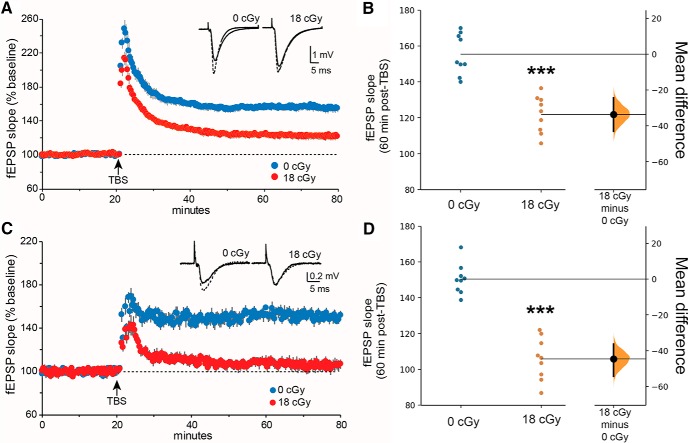
Neutron irradiation alters long-term synaptic plasticity in the hippocampal area CA1 and ventral medial prefrontal cortex. A, B, Extracellular field recordings following stimulation of the Schaffer-commissural projections to the proximal apical dendrites of field CA1b of the dorsal hippocampus, 6 months following completion of the 18 cGy neutron irradiation. A, Following a stable 20 min baseline recording, a single train of TBS was applied and baseline recordings were resumed for an additional 60 min. The time course shows that TBS-induced LTP was markedly reduced in slices from irradiated mice compared with slices from 0 cGy control mice. Inset, Representative traces collected during baseline (solid line) and 60 min post-TBS (dotted line). B, Field EPSP slope was significantly reduced 60 min post-TBS in slices from the neutron-irradiated mice compared with controls. C, D, Field responses recorded in cortical layer III following stimulation of glutamatergic inputs in cortical layer IV of the ventral medial prefrontal cortex. C, Similar results were obtained as shown in A. TBS-induced LTP was nearly completely blocked in slices from neutron-irradiated mice relative to controls. Inset, Representative traces collected during baseline (solid line) and 60 min post-TBS (dotted line). D, Field EPSP slope was significantly reduced 60 min post-TBS in slices from 18 cGy mice compared with controls. N = 9 slices per group. ***p < 0.0001 (two-tailed t test).